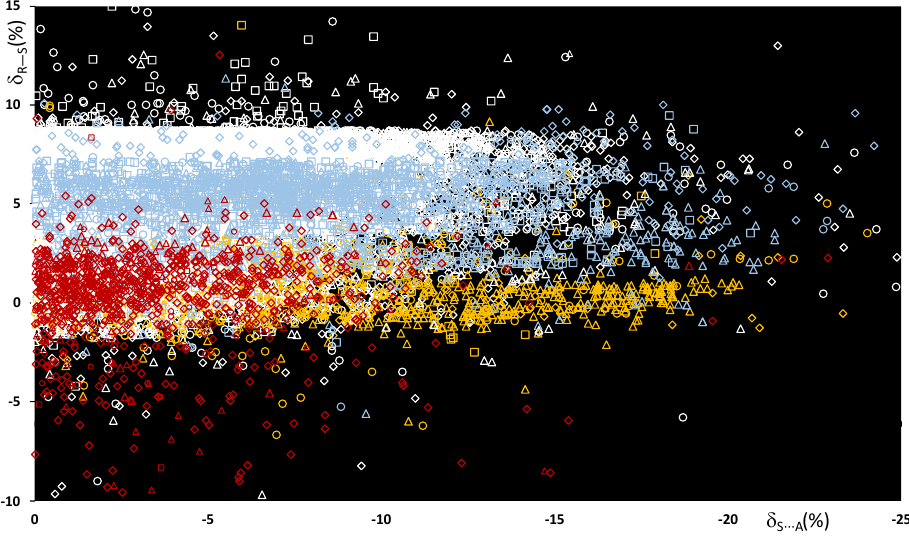
Figure 3. Scatterplot of the δ R – S vs. δ S···A functions calculated for all fragments R – S···A. R = C (white), O (red), N (light blue), and S (yellow); A = N (square), Ch (circle), O (rhomb), and Ha (triangle). In Figure 3, the color code represents the nature of the R atom, and the shape repre- sents the nature of the A ChB acceptors, grouped by category. The examination of the normalized data shows that the relative R –S stretching distances δ R – S do not depend on the atomic radii of the atoms involved, but on the type of atom directly bound to the cen- tral sulfu r. It can be noted that the functions δ C – S and δ N – S , calculated for systems with either a C – S or an N – S covalent bond, fall within a range of 0% – 9%. On the contrary, when either an O – S or an S –S bond is present, smaller δ R – S values are found, and δ O – S and δ R – S are mainly in the range of −2% to 2%. An analysis of the δ S···A values allows the strengths of the ChBs in the R – S···A frag- ments to be evaluated and compared. The strength of the S···A interaction is indeed di- rectly related to the interaction energy and not to the structural distances. However, sev- eral theoretical studies correlate interaction energies and key geometric parameters and show that stronger interactions usually correspond to reduced intermolecular S···A dis- tances [30, 36, 37 ], and hence to more negative δ S···A values. For all the systems examined, the δ S···A values range from 0% to −25%, with 88% being between 0% and – 15%. It is inter- esting to note that although examples of the different R – S···A categories can be found all over the range, the region corresponding to shorter interactions ( δ S···A < – 15%) is mostly populated by fragments with N – S and S – S bonds, whereas fragments with an O – S bond fall mainly in the region of long interactions, with δ S···A between 0% and −10%. These results agree very well with the recent study by P.A. Wood et al. on σ -hole interactions in small molecules containing divalent sulfur groups R 1 – S – R 2 [38]. The scat- terplot does not show a clear role for the acceptor A, although ionic systems in which the ChBs involve A = Br − and I − as the ChB acceptors show Ch···A interaction distances re- markably shorter than the sum of the relevant vdW radii. The relative variations were used to calculate the mean δ̅ S···A values for the different categories of R – S···A fragments (R = C, N, O, and S; A = N, O, S, F, Cl, Br, and I), and the resulting data are presented in Table 1 and Figure 4 (color code: R = C (grey), N (blue), O (red), S (yellow)). Despite the wide variety of systems included, the mean δ̅ S···A values show significant results. The shortening of the Ch···A interaction distance, which can be related to the strength of the relative ChB, increases in the order of O < C < S < N, except when A is a soft halide species (Br − and I − ). On the contrary, there is no clear trend regarding the role